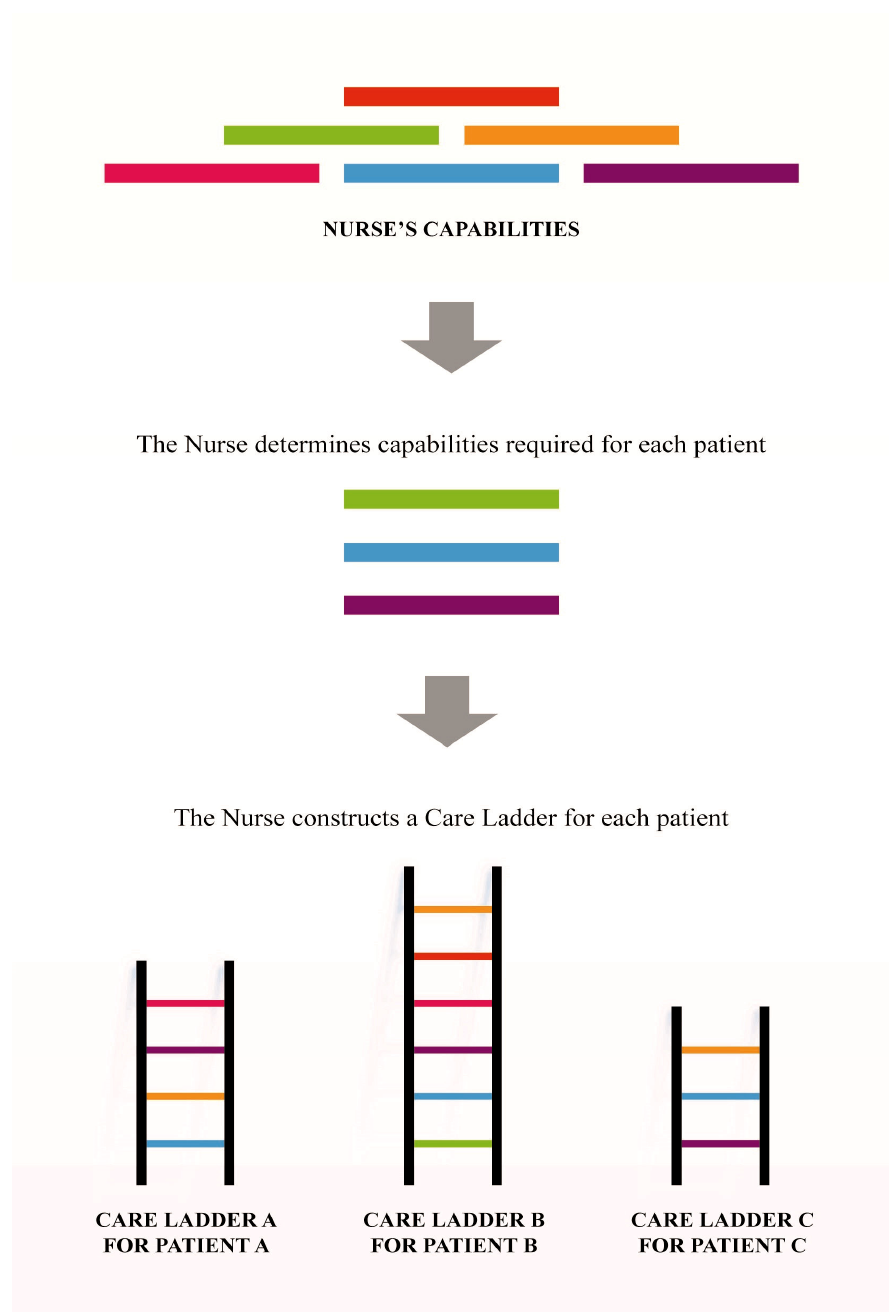
Figure 1. Distinctiveness of the nurse’s care ladder.